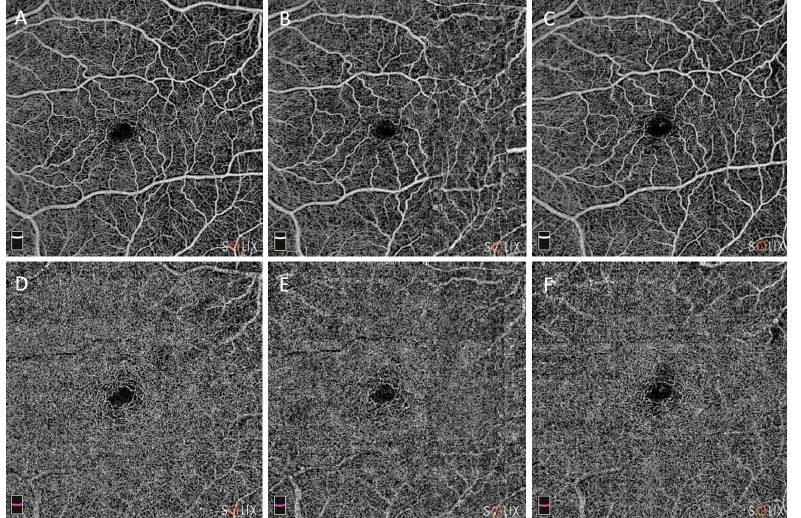
Figure 1. AngioVue Retina images of macular vascularization during the follow ups, in 6.4 × 6.4 mm scans. Upper images highlight the superficial capillary plexus (SCP): baseline ( A ), one week after cataract surgery ( B ) and one month after surgery ( C ). At last follow up, a significant increase in both whole image and foveal vascular density were reported (from 48.3% at T0, to 48.4 at T7, to 51.9% at T30). Similarly, the lower images show the deep capillary plexus (DCP) evolution at T0 ( D ), T7 ( E ) and T30 ( F ). DCP vascular density improved from 50.1% at T0, to 49.8% at T7 and finally to 54.0% at